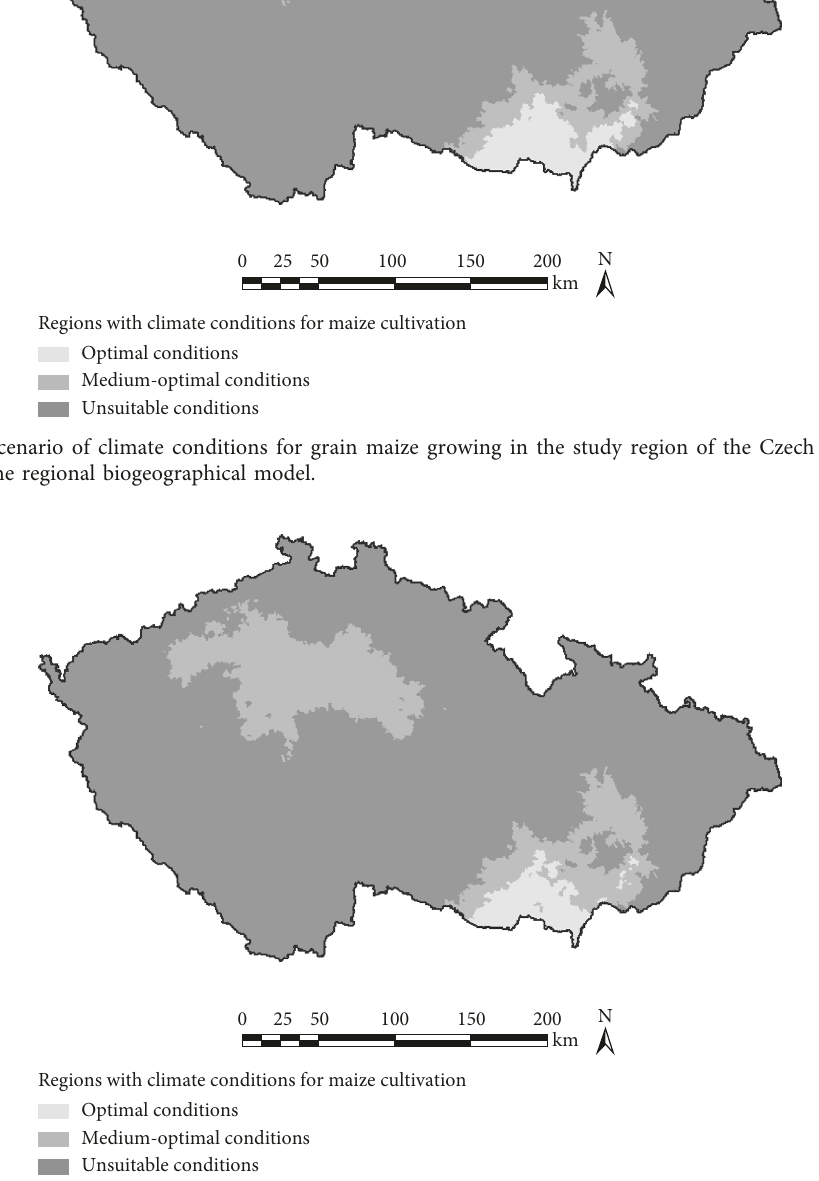
Figure 4: Prediction scenario of climate conditions for grain maize growing in the study region of the Czech Republic in the period 2031–2050, based on the regional biogeographical